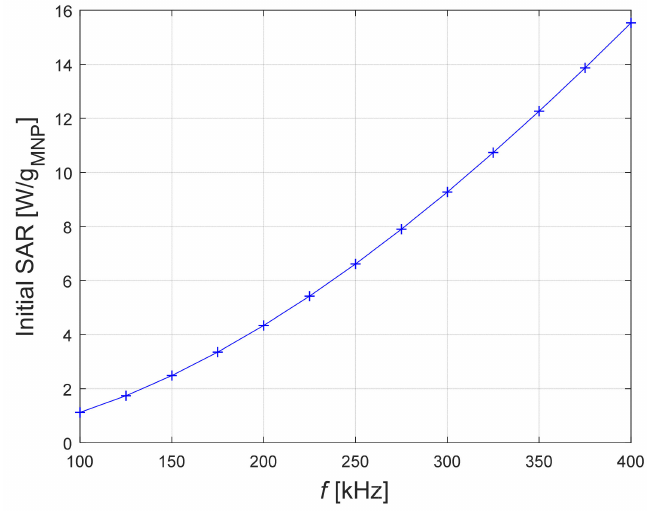
Figure 22. Initial SAR dependence on frequency at the magnetic field strength amplitude being H = 7.83